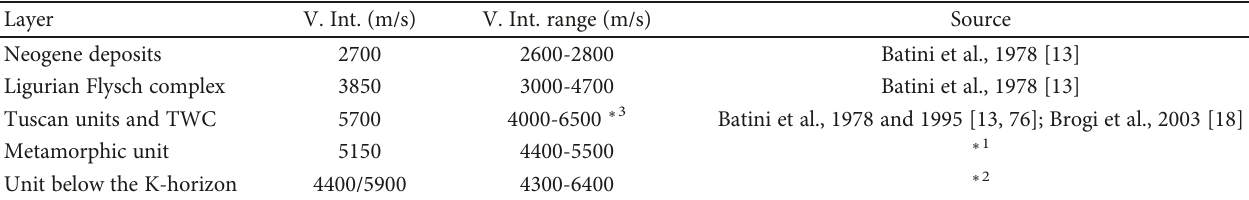
Unit below the K-horizon ∗ 2 ∗ 1 Batini et al., 1978 and 1995 [13, 76]; Bertani et al., 2005 [9]; Brogi et al., 2003 [18]; Rabbel et al., 2017 [6]. ∗ 2 Batini et al., 1995 and 2002 [70, 76]; Vanorio et al., 2004 [20]; Tinivella et al., 2005 [72]; Aleardi and Mazzotti, 2014 [73]; Rabbel et al., 2017 [6]. ∗ 3 In Brogi et al., 2003 [18], the Tuscan Nappe is divided in two subunits which are the TN 2 (Early Miocene-Rhetic sequence) and the TN 1 (Late Triassic evaporites) with 4000-4500m/s and 5000-6500m/s of P-wave interval velocity,